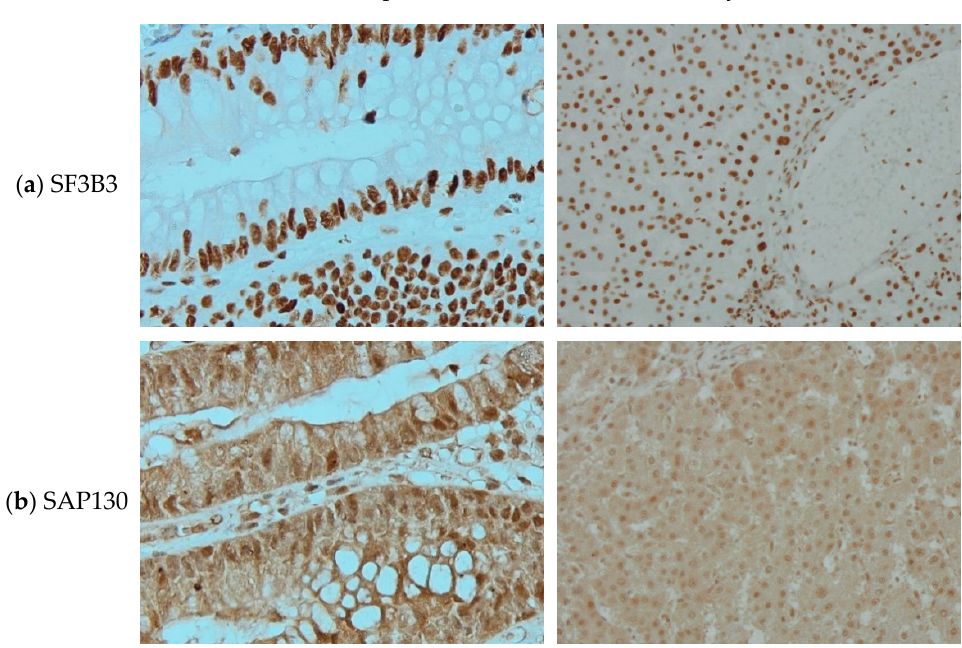
Figure 1. Immunohistochemistry staining of ( a ) splicing factor 3b subunit 3 (SF3B3) and ( b ) Sin3A associated protein 130 (SAP130) in (left) inflamed ileum epithelium, imaged at 40 × magnification and (right) healthy liver tissue, imaged at 20 ×